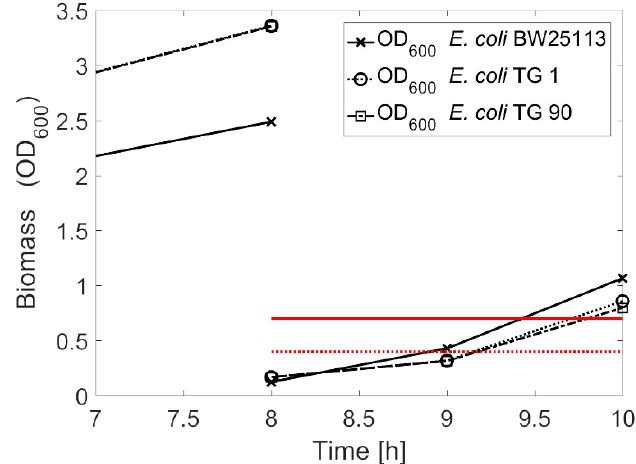
Figure 4. Batch cultivation approach for harvesting of competent cells with Preculture (0–8 h) and a main cultivation (8–10 h). Lower dotted red line: threshold of sampling interval adaptation; upper red line threshold for harvesting. The square of E. coli TG 90 is mostly hidden under the circle of E. coli TG 1.